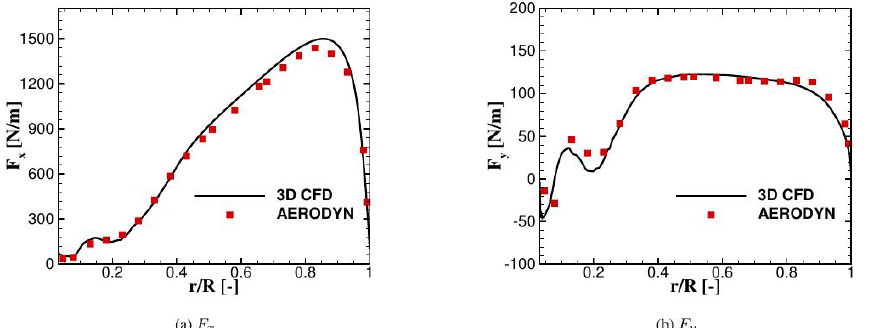
Figure 2. Normal (on the left) and tangential (on the right) sectional load in comparison for a single rigid blade 3D CFD vs. AeroDyn.